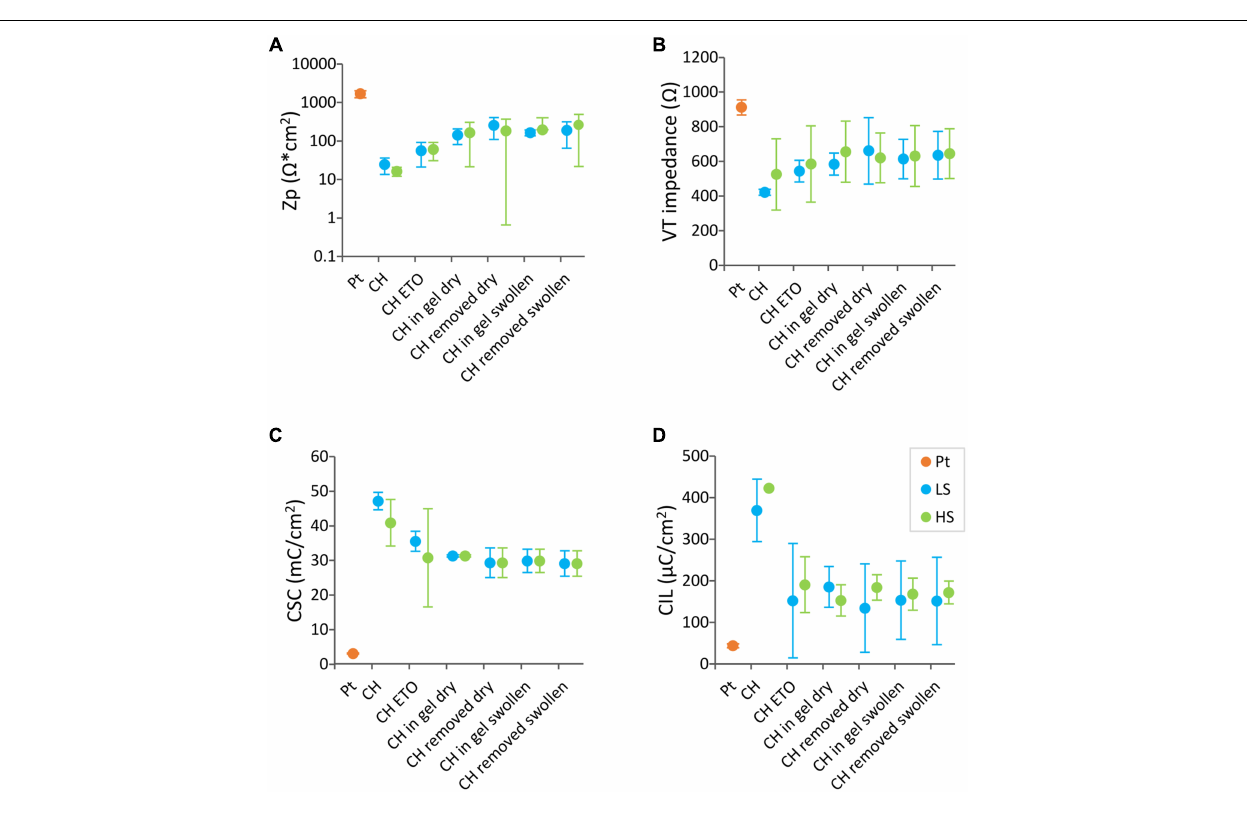
FIGURE 5 | Electrochemical properties of CH-coated electrode arrays in different conditions. Pt electrode arrays ( n = 4) were CH-coated with the low swelling (LS) formulation ( n = 2) (blue) or with the high swelling (HS) reference formulation ( n = 2) (green). Each data point represent the average of arrays (each array is the average of four electrode sites). (A) polarisation impedance (Zp), (B) voltage transient (VT) impedance, (C) charges storage capacity (CSC), and (D) charge injection limit (CIL). The electrochemical properties were assessed following ethylene oxide sterilisation, (ETO) then upon insertion in agarose gels with the CH coating dry (Inserted Dry). Arrays were removed, assessed (Removed) and then inserted with the CH coating swollen (Inserted Swollen) in a new agarose gel and removed for a final